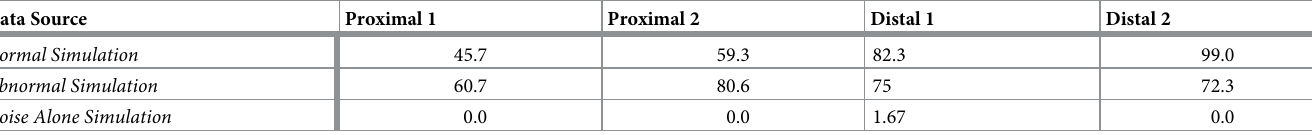
Table 1. Percentage of time that PGD > 0.5 for inverse results via simulation type and region.